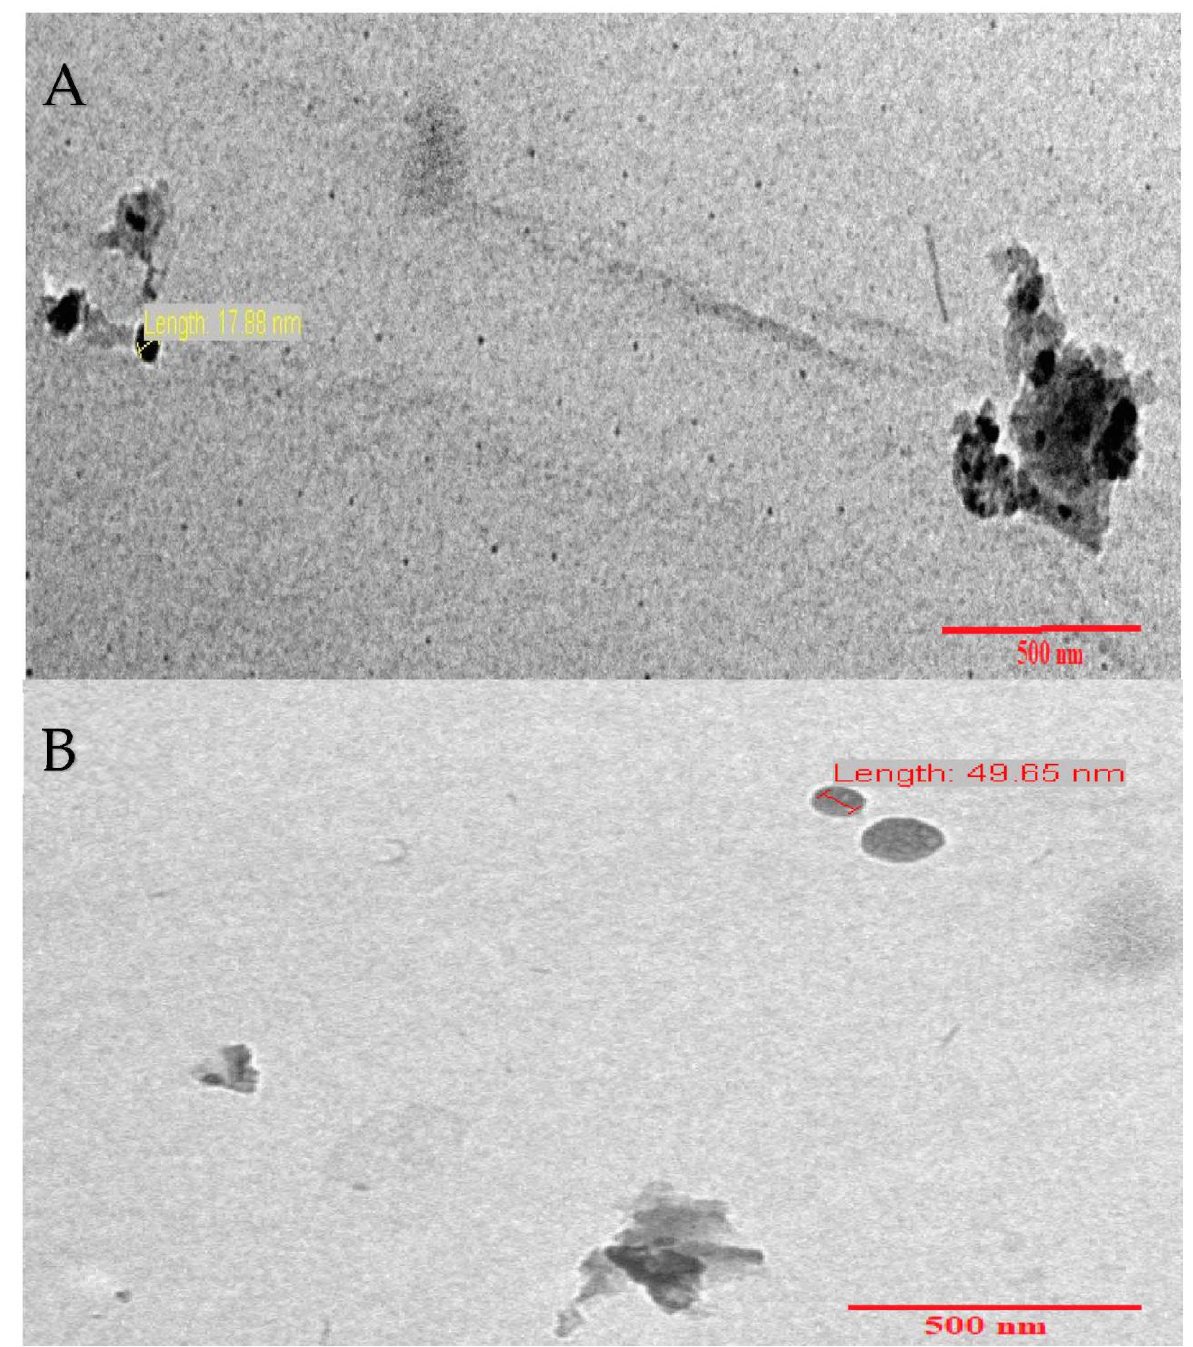
Figure 6. ( A , B ) TEM image of CCsMFO nanocomposite.